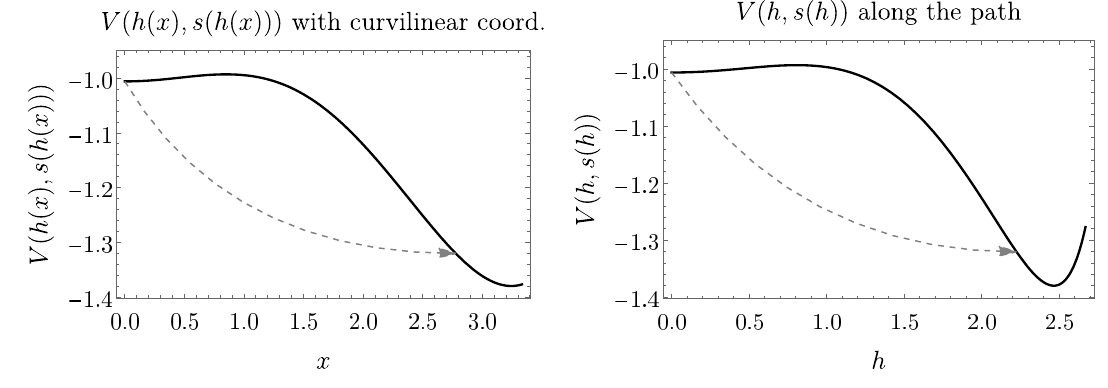
Figure 9 . On the left, the potential, along the path, experienced by the field x and the corre- sponding escape point x ? . On the right the potential, along the path, projected on the h